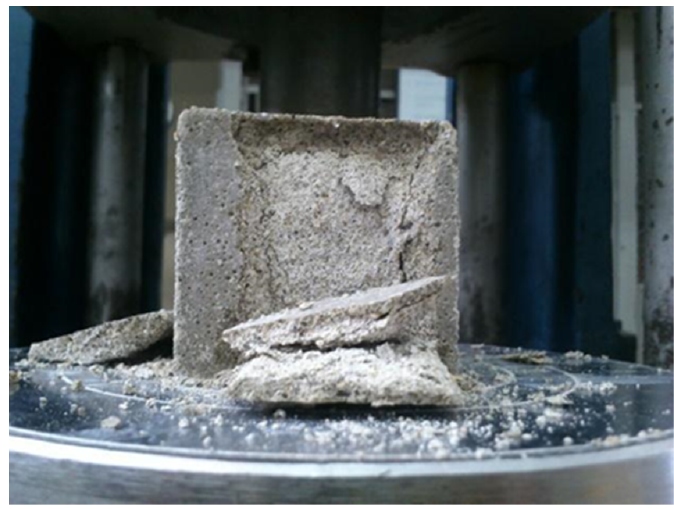
Figure 4. Illustration of the compressive strength test.